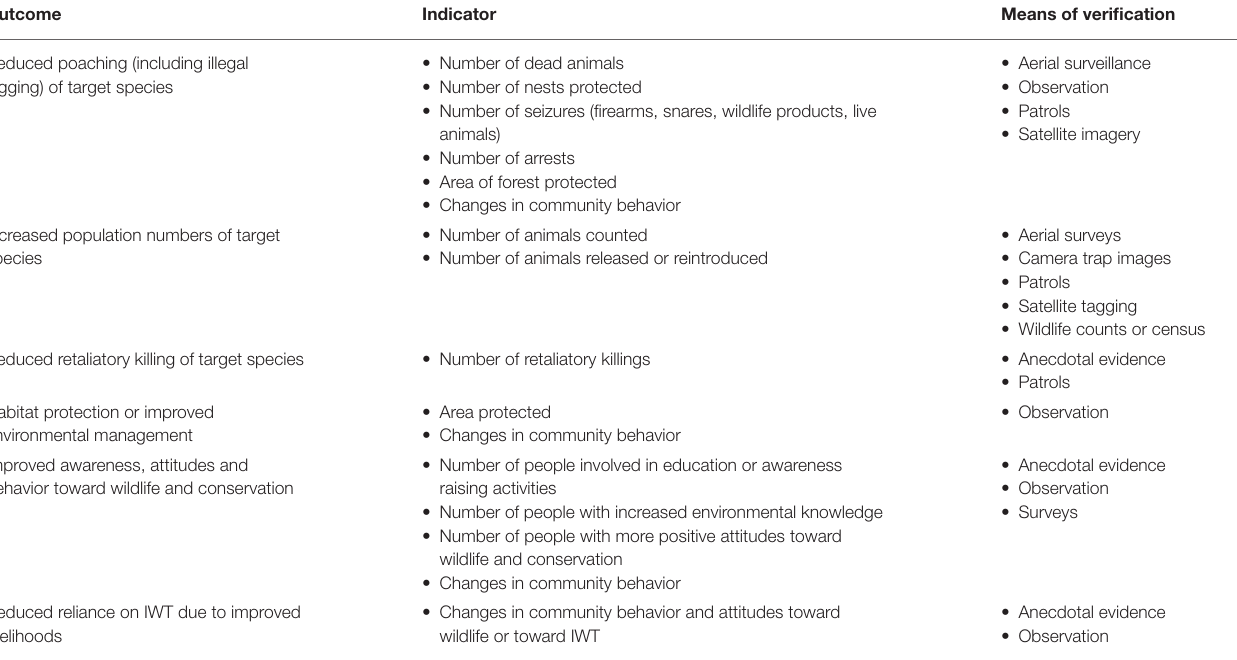
TABLE 1 | Typology of frequently reported outcomes from community-based anti-poaching interventions that are either effective or partially effective at reducing IWT and documented on the People not Poaching platform, with information on common indicators and their means of verification. Outcome Indicator Means of verification Reduced poaching (including illegal logging) of target